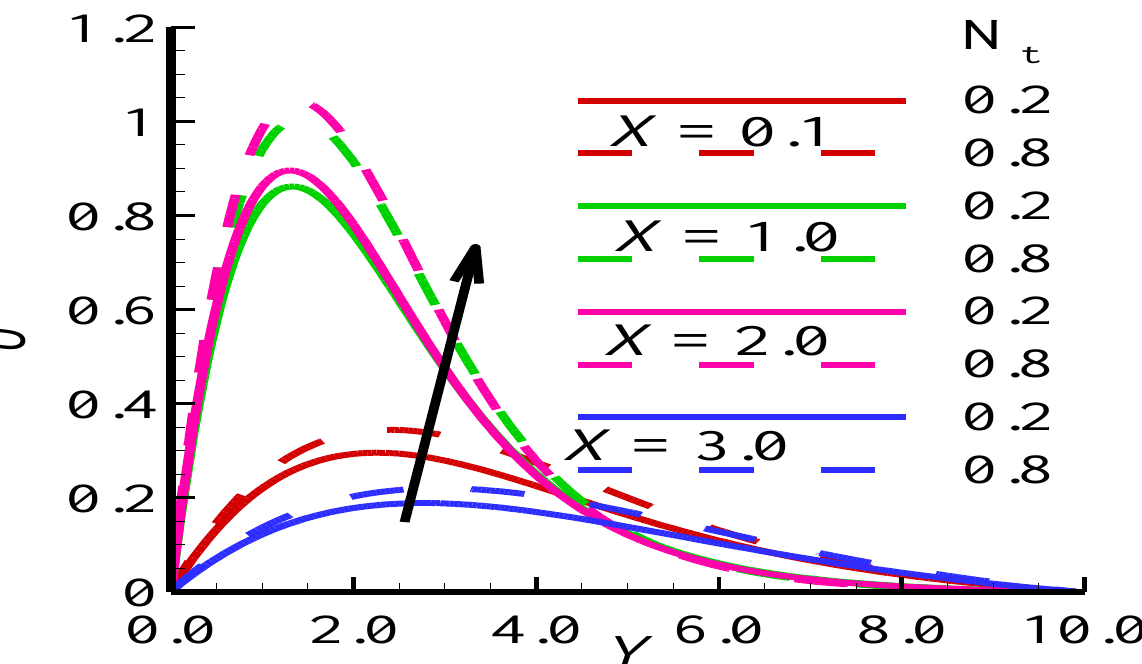
Figure 4. Outcomes of radiation parameter N on mass concentration φ when Nb = 1.5, Nt = 1.5, Pr = 7.0, and Sc = 10.0.